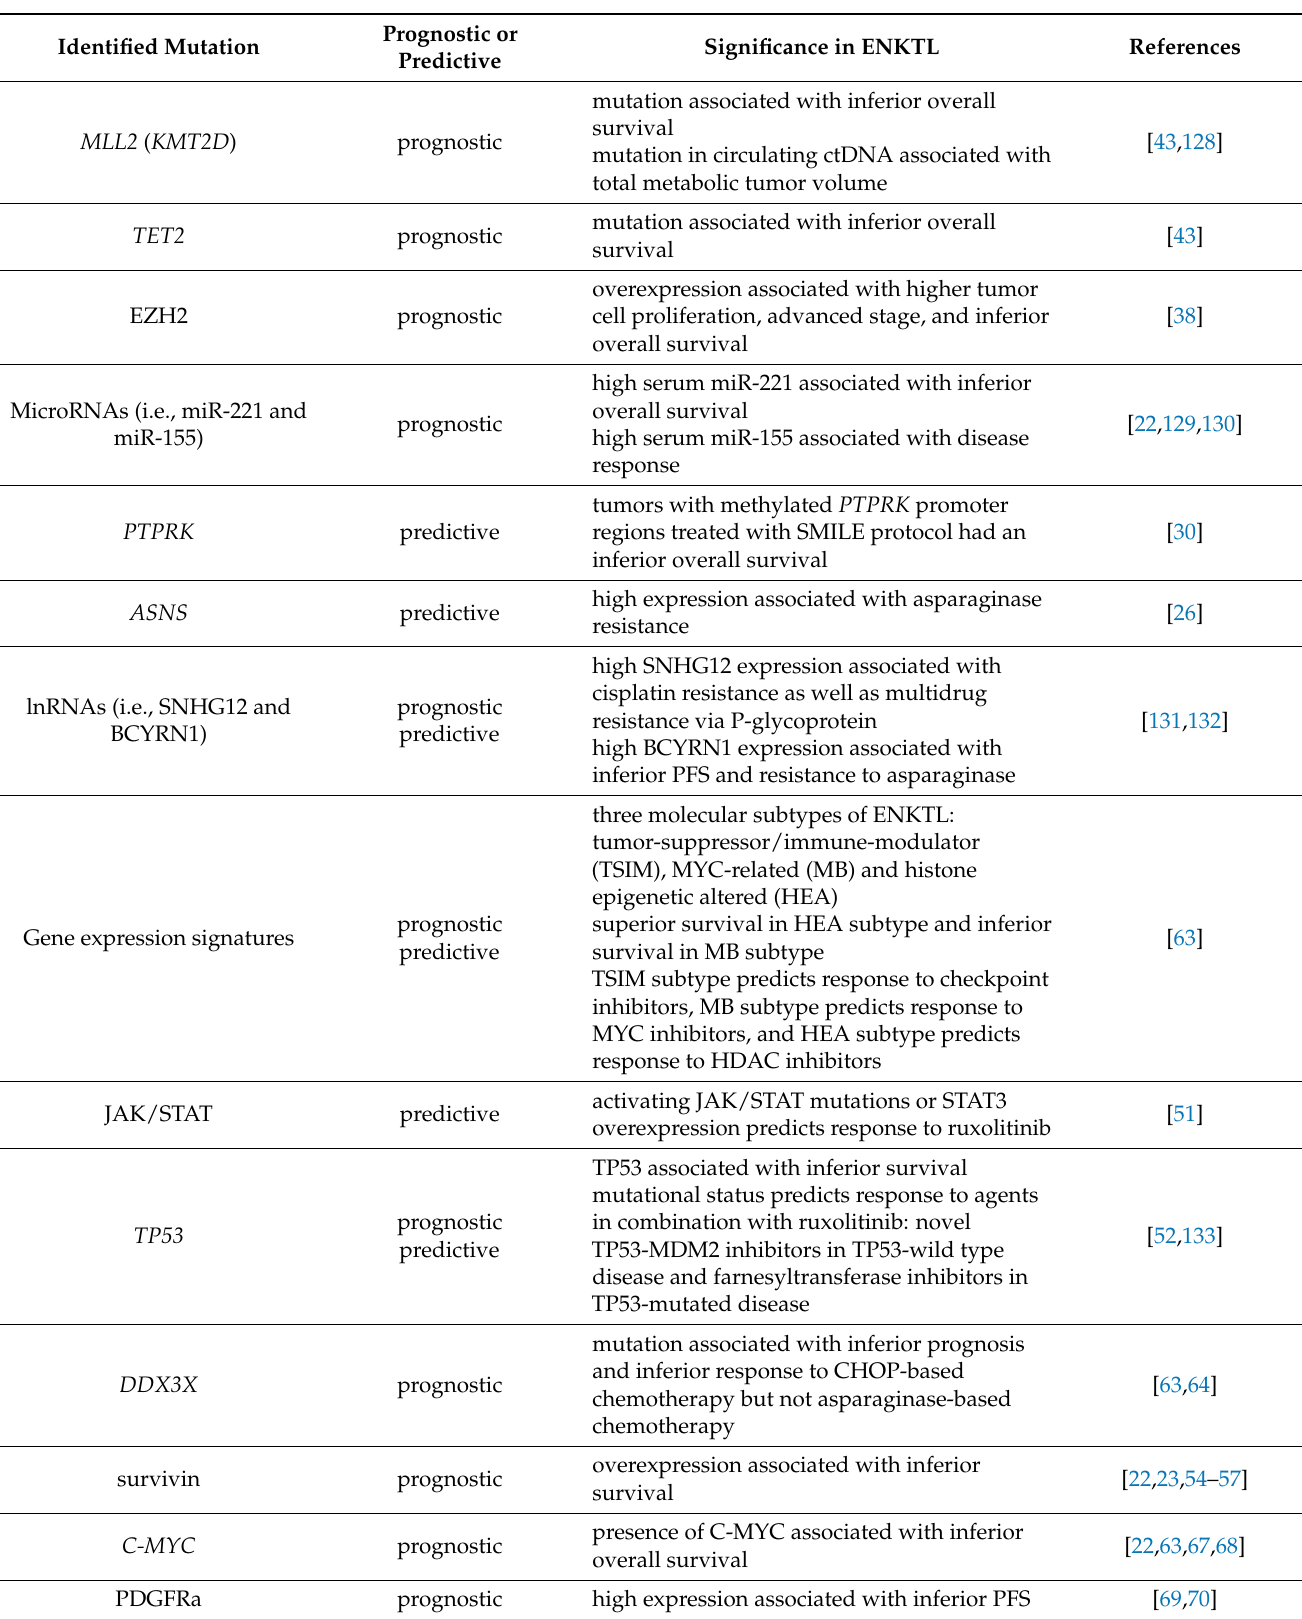
Table 2. Prognostic and predictive biomarkers in